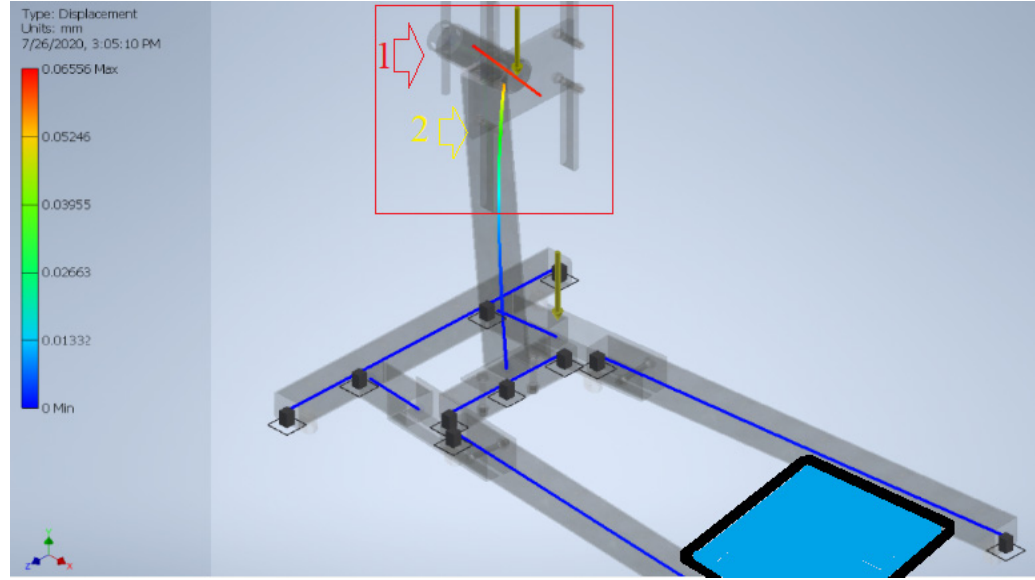
Figure 10. Robotic arm in displacement analysis stage: ( a ) critical area; ( b ) second-level displacement.